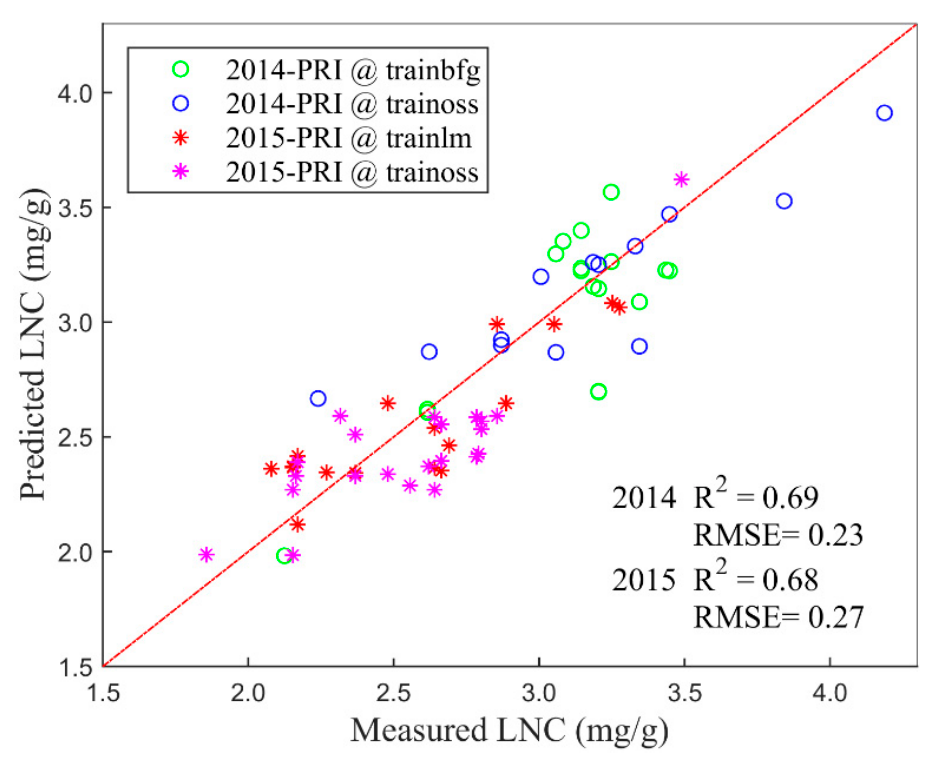
Figure 4. Performance of PRI in LNC estimation, the R 2 and RMSE are the mean values of 2014- and 2015-year data.